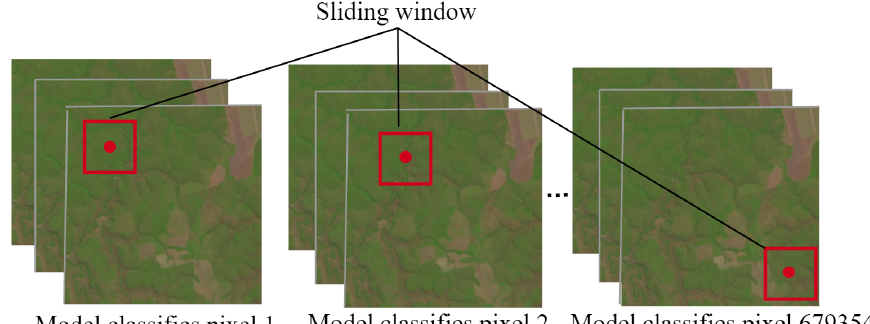
Figure 6. Example of crop identification based on patch